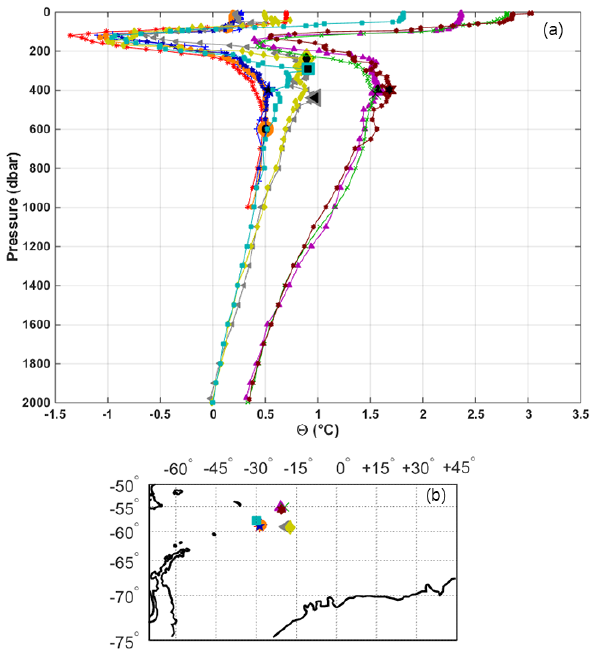
Figure 5. A random sample of pressure (dbar)–conservative tem- perature ( ◦ C) profiles from Argo floats within the regions 15–30 ◦ W and 55–60 ◦ S (a) and the corresponding locations of the profiles (b) . The sub-surface temperature maximum of each profile is marked with an enlarged